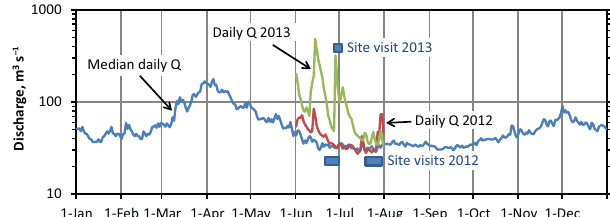
Figure 3. Median daily river discharge ( Q) based on the pe- riod of record 1975–2012 (USGS station number 01427510; http: //waterdata.usgs.gov/nwis). Daily-average Q also is plotted during June–July 2012 and June–July 2013. Periods of site visits during 22 June–1 July 2012, 20–30 July 2012, and 28 June–2 July 2013, are shown as blue